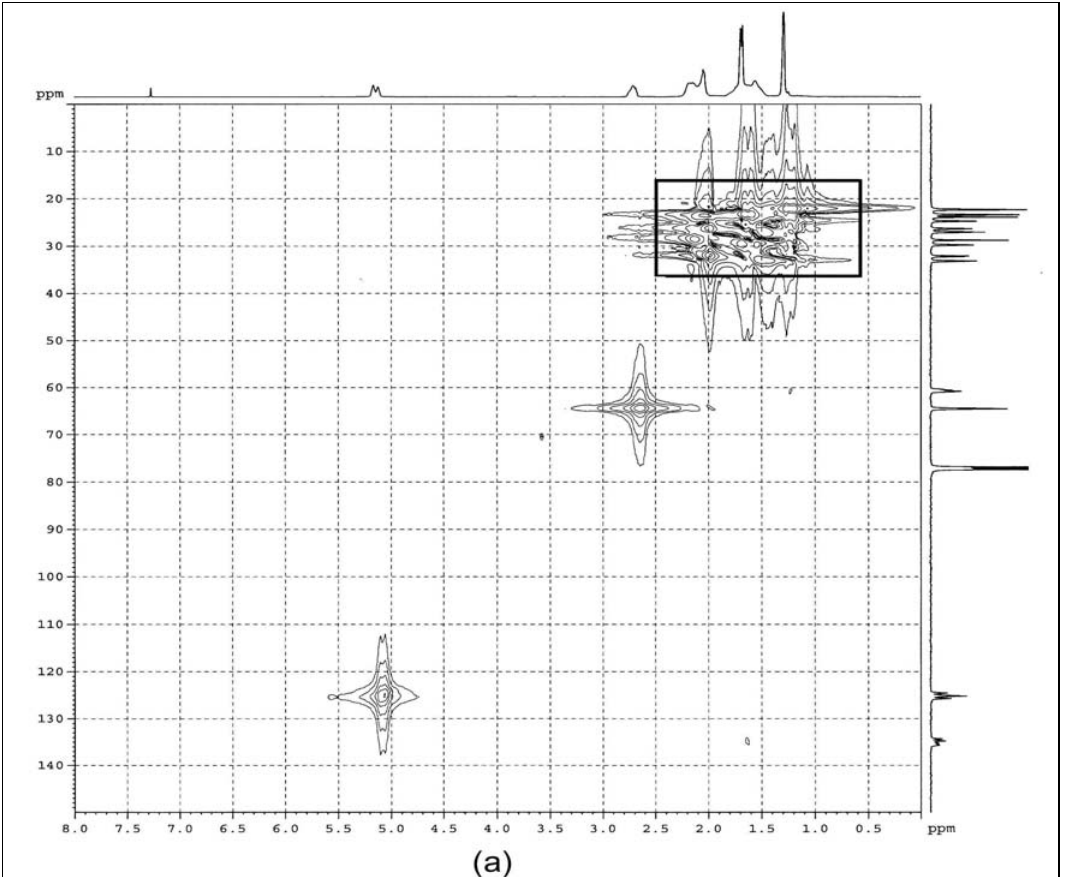
Figure 4. HMQC spectra of ( a ) purified ENR-50 and ( b ) enlargement of the boxed region in ( a